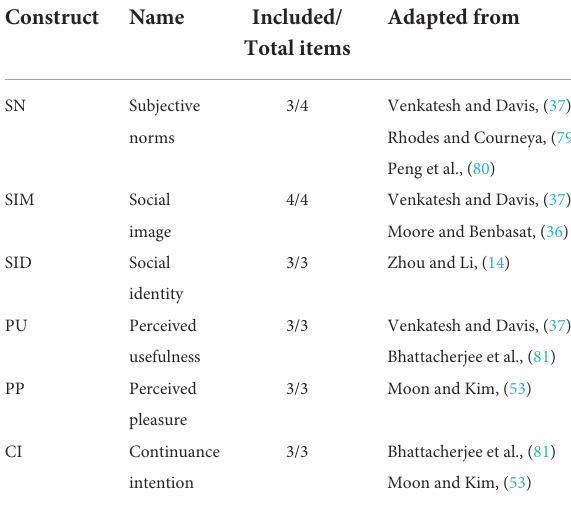
TABLE 2 Measurement